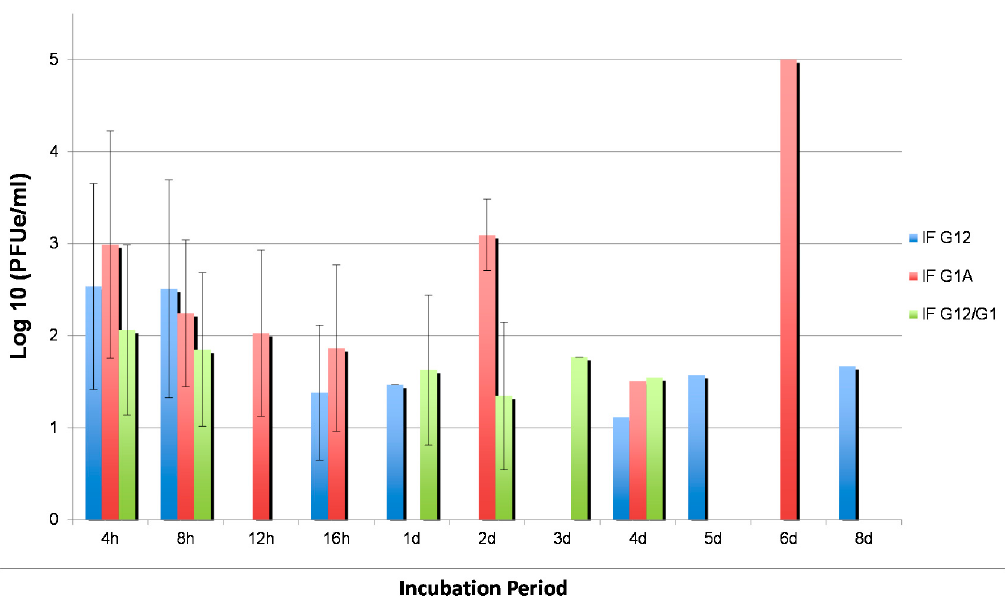
Figure 4. Titration of WNV in RNAi injected Cx. quinquefasciatus (CPQG) midguts dissected at different incubation periods post WNV infection. h, hours; d, days; IFG12, injected with CQ G12A2 RNAi; IFG1A1, injected with CQ G1A1 RNAi; IF12.1, injected with CQ G12A2 and CQ G1A1 RNAi.